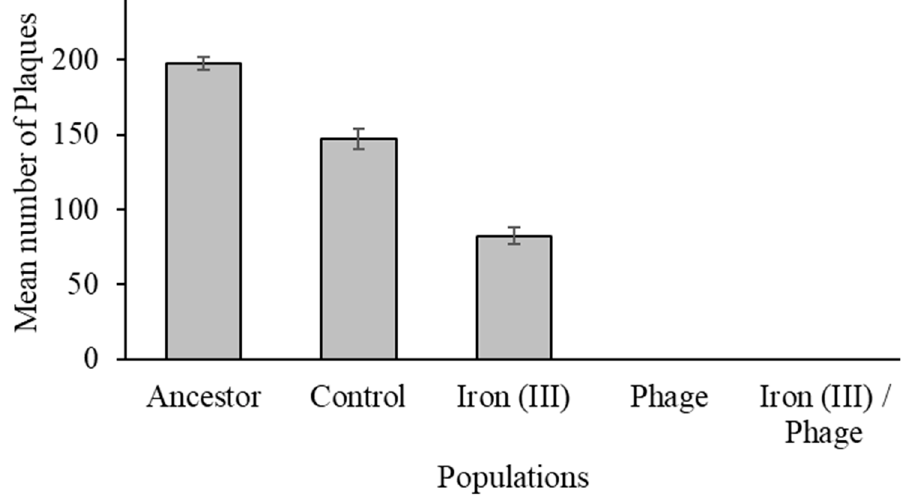
Figure 3. Resistance of populations to Escherichia phage T7. Mean number of plaques represents an average of 12 replicates and SE per population. Phage-resistant and iron (III)/phage-resistant populations were not susceptible to T7 bacteriophage attack. Ancestral population was least resistant to lytic phage attack, followed by the control and iron (III)-resistant populations. Differences in resistance to T7 bacteriophage were significant at 95% confidence interval among populations. To determine dual resistance in each population, an assay was performed to estimate